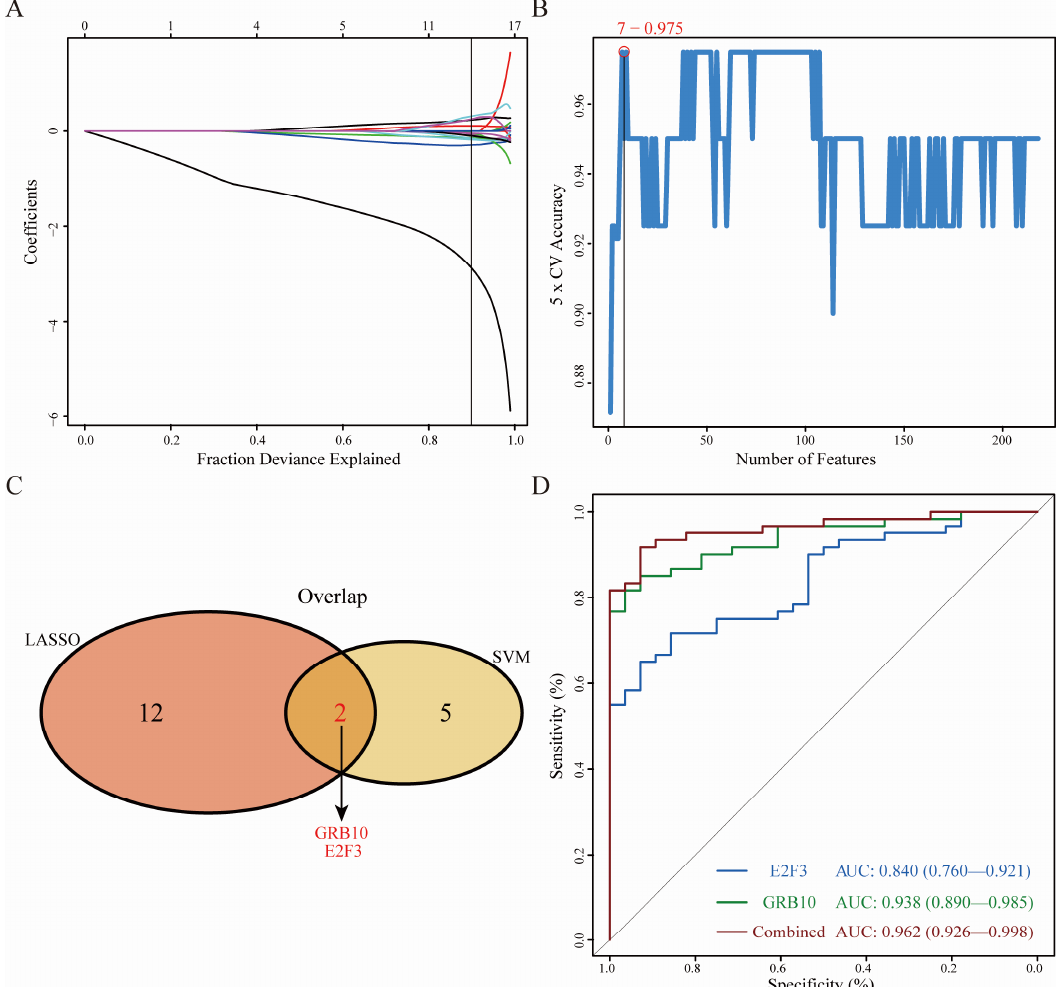
Figure 5. Screening and verification of diagnostic markers. ( A ) Least absolute shrinkage and selection operator (LASSO) logistic regression algorithm to screen diagnostic markers. Different colors represent different genes. ( B ) Support vector machine-recursive feature elimination (SVM-RFE) algorithm to screen diagnostic markers. ( C ) Venn diagram shows the intersection of diagnostic markers obtained by the two algorithms. ( D ) The ROC curve of the diagnostic efficacy verification after fitting two diagnostic markers to one variable.